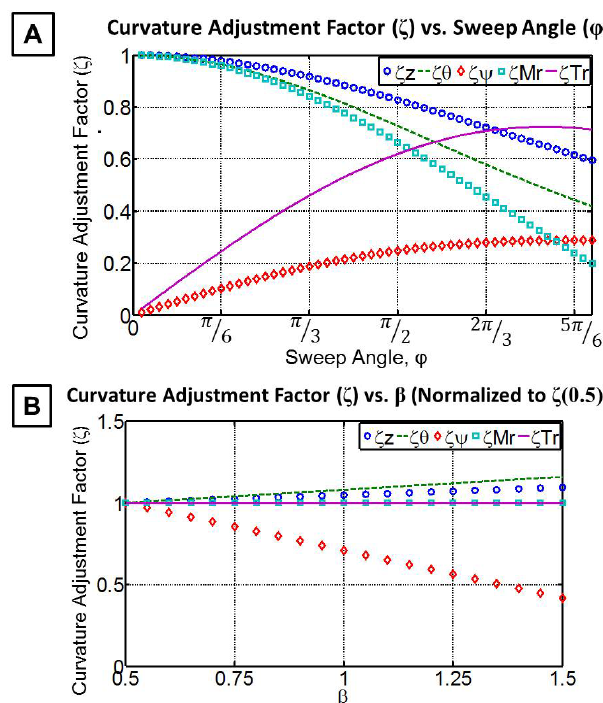
Figure 5. The curvature adjustment factors, ζ , show how the be- havior of the curve beam deviates from that of a straight beam as a function of the geometry of the beam. Curvature adjustment factors are obtained from Roark’s closed-form solutions. ζ z corresponds to the z-axis displacement multiplier as shown in Eq. (7), while ζ θ and ζ Ψ correspond to the multipliers for the two parasitic motions θ and Ψ , respectively. Finally ζ M and ζ T represent the curvature r r adjustment factors for the resulting moment and torque at the base of the beam. Flexure length is held constant by varying the radius of curvature. (A) Curvature adjustment factors, ζ , vs. sweep angle, φ . The graph shows that as the sweep angle goes to zero the curved beam behaves as a straight beam, ζ z , ζ θ , ζ M go to 1, and ζ Ψ and ζ T r r approach zero. While as the sweep angle increases the behavior of the curved beam deviates from that of the straight beam. (B) Cur- vature adjustment factors, ζ , vs. β , β is the ratio of elastic to shear properties of a curved beam as defined by Eq.